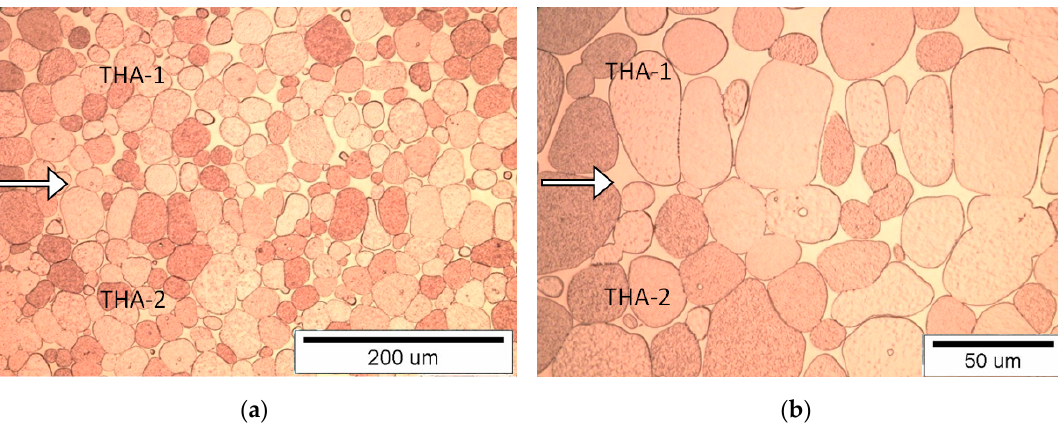
Figure 7. View of the microstructure of the THA-1 with THA-2 (with THA-1 on the top) at a magnification of 200× ( a ) and 500× ( b ), (the connection line (joint) is shown by the arrow).